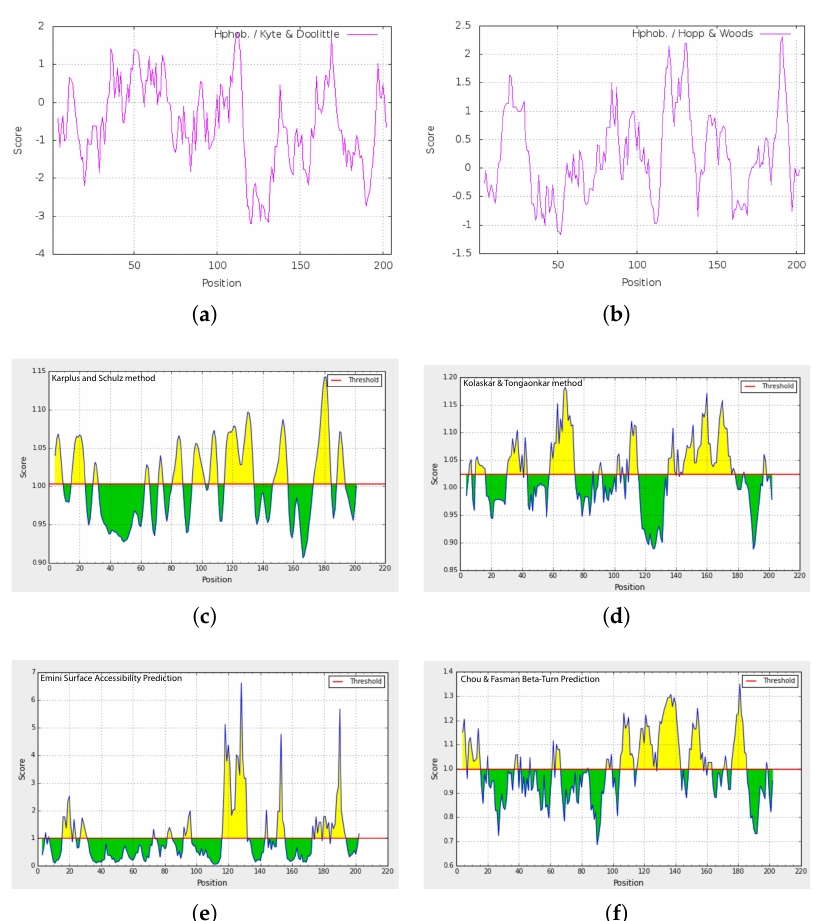
Figure 6. Hydrophatic profiles of the cLin-28 protein. Plots have amino acid sequence positions on the x-axis, and the degree of hydrophobicity and hydrophilicity on the y-axis. ( a ) Kyte–Doolittle method: the points above the midpoint line denote the hydrophopic regions and those below the midpoint line indicate hydrophilic regions of the cLin-28 protein. ( b ) Hydrophilicity plot for cLin-28 protein using the Hopp and Wood method. ( c ) Karplus and Schulz flexibility prediction of the cLin-28 protein. The x-axis and y-axis represent the position and score, respectively. The threshold is 1.0. The flexible regions of the protein above the threshold value are shown in yellow. ( d ) Kolashkar and Tongaonkar antigenicity prediction of the most antigenic regions of the cLin-28 protein. The threshold value is 1.0. The regions above the threshold are antigenic and are shown in yellow. ( e ) Emini surface accessibility prediction of the cLin-28 protein. The threshold value is 1.000. The regions above the threshold are antigenic and are shown in yellow. ( f ) Chou and Fasman β -turns prediction of clin-28 protein. The threshold is 1.00. The regions with β -turns in the protein are shown in